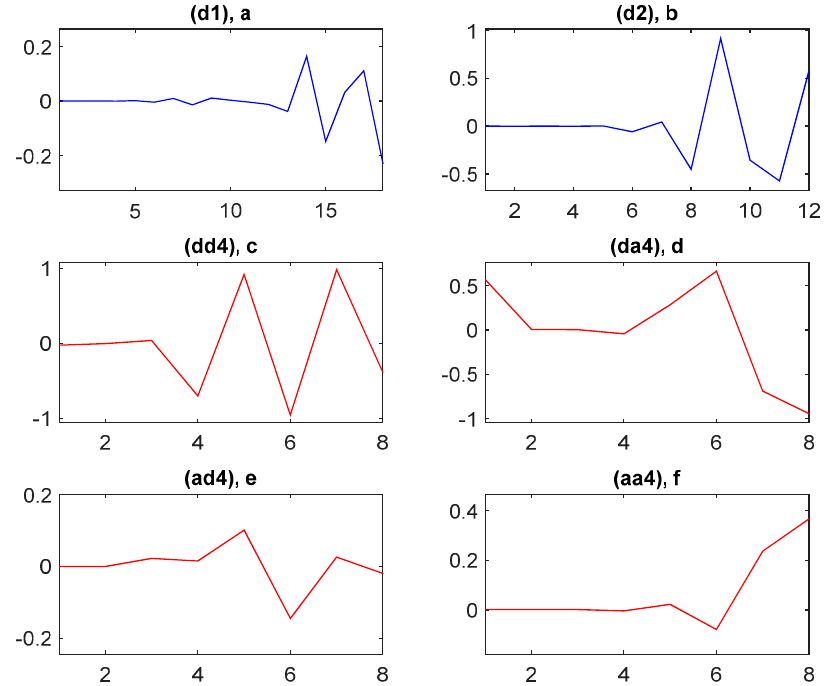
Figure 9. Example of subband coefficients of a RBBB QRS complex segment, where the y -axis is the normalized amplitude and x -axis is the number of coefficients. ( a ) shows coefficients of the subband d1, ( b ) shows coefficients of the subband d2, ( c ) shows coefficients of the subband dd4, ( d ) shows coefficients of the subband da4, ( e ) shows coefficients of the subband ad4, and ( f ) shows coefficients of the subband aa4.